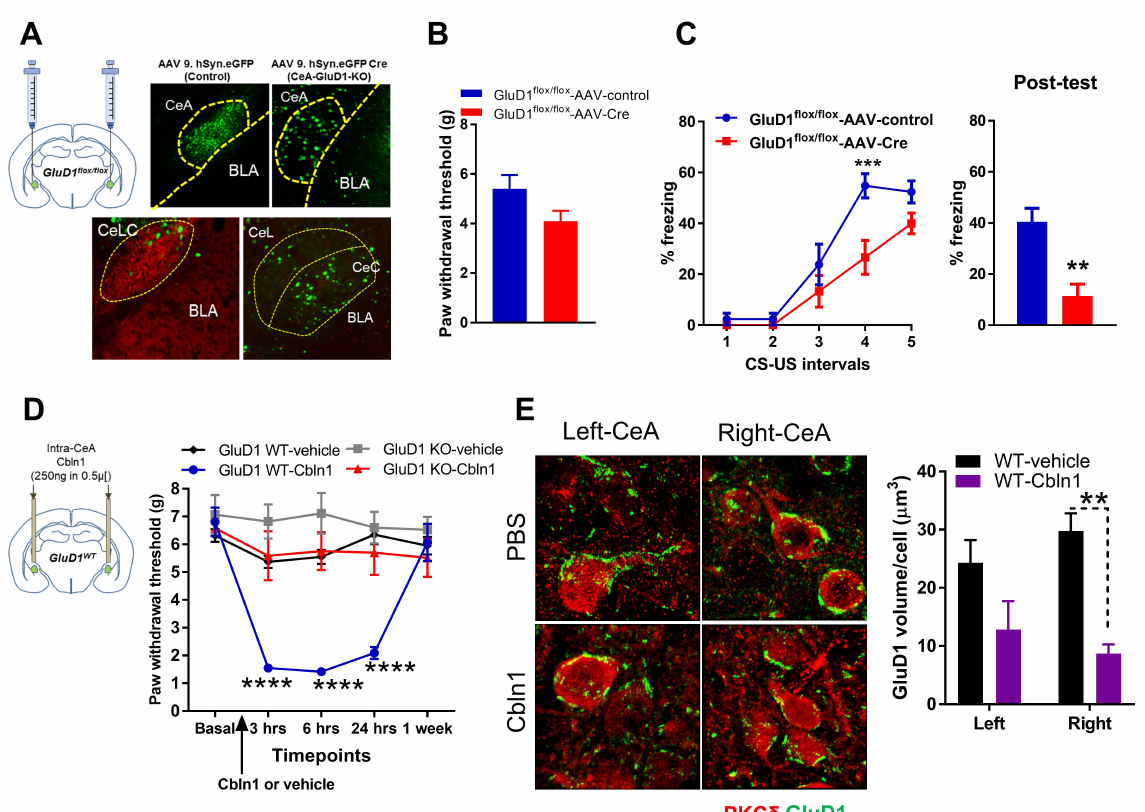
Figure 8. Recombinant Cbln1 in CeA increases mechanical hypersensitivity in normal animals. ( A ) Local deletion of GluD1 in the CeA using AAV constructs. Conditional deletion of GluD1 from CeA was achieved using Cre-lox strategy. Mice were injected with with AAV9-hsyn-eGFP or AAV9-hsyn-eGFP-Cre, bilaterally into CeA. Deletion of GluD1 from CeA was confirmed by immunohistochemistry. ( B ) Deletion of GluD1 from the CeA does not lead to significant change in mechanical hypersensitivity. ( C ) Impaired averse fear learning in mouse with GluD1 ablation in the CeA. Significant deficits in fear acquisition at 4th CS US (Two-way repeated measures ANOVA, F (1, 10) = 6.31, p = 0.031; Bonferroni’s post hoc test, 4th CS-US: AAV-control ( n = 7 mice) vs. AAV-Cre ( n = 5 mice): 54.764 ± 4.765 vs. 26.66 ± 6.665, *** p = 0.0008) as well as in retrieval 24 h later (AAV-control vs. AAV-Cre: 40.47 ± 5.282 vs. 11.46 ± 4.619, ** p < 0.005, Unpaired t-test with Welch correction). ( D ) Mice underwent cannulation surgery for the implantation of bilateral CeA cannulas. Effect of recombinant Cbln1 (250 ng in 0.5 µ L) injected into CeA of naïve mice. After measuring basal mechanical hypersensitivity, Cbln1